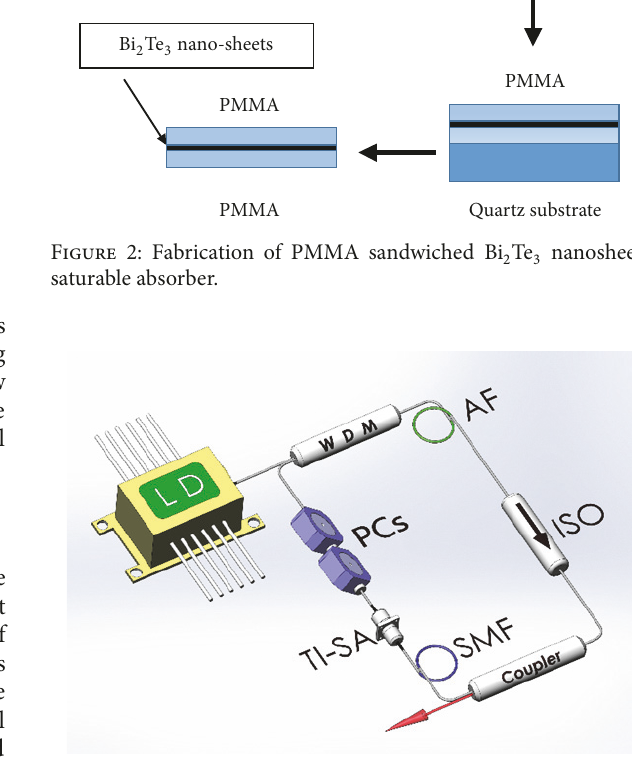
Figure 3: The schematic of mode-locked fiber